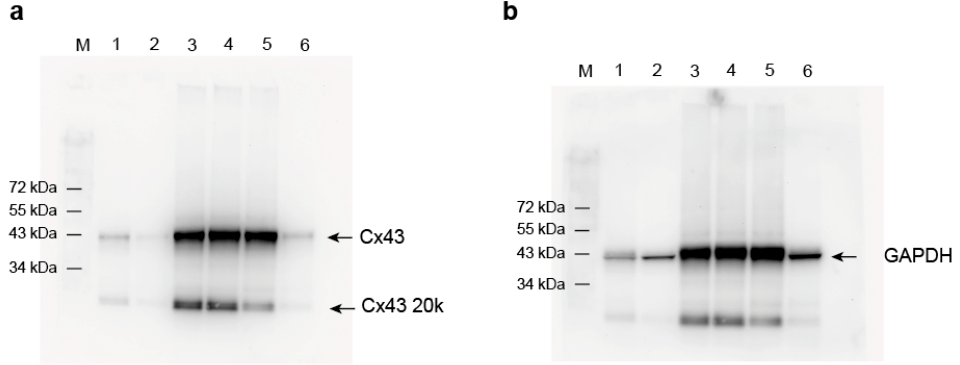
Figure A1. Whole size Western blots—detection of Cx43 after siRNA transfection. ( a ) Cx43 was detected after treatment with control siRNA and Cx43 siRNA, respectively. In addition, the short Cx43 isoform (GJA 1-20k; denoted as Cx43 20k in figure) was detected and shown to be downregulated by Cx43 siRNA. Lanes 1–2 are displayed in Figure 1b. ( b ) GAPDH was detected as a loading control. Traces of Cx43 protein bands can also be seen as the membrane was not stripped between antibody incubations. Lanes 1–2 are displayed in Figure 1b. M: Protein size marker.